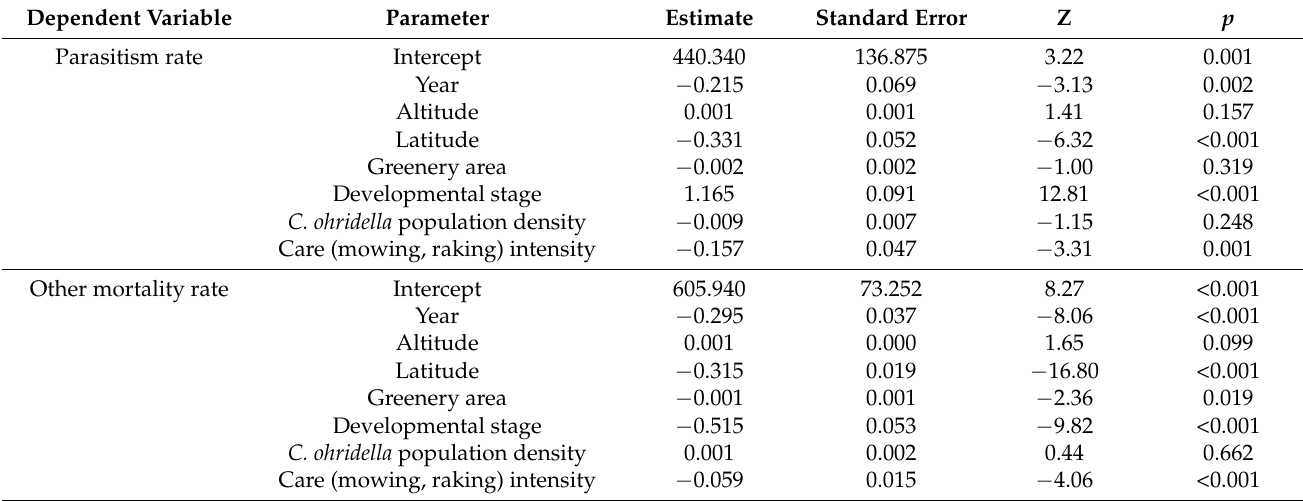
Table 2. Results of the analysis of GEE parameter